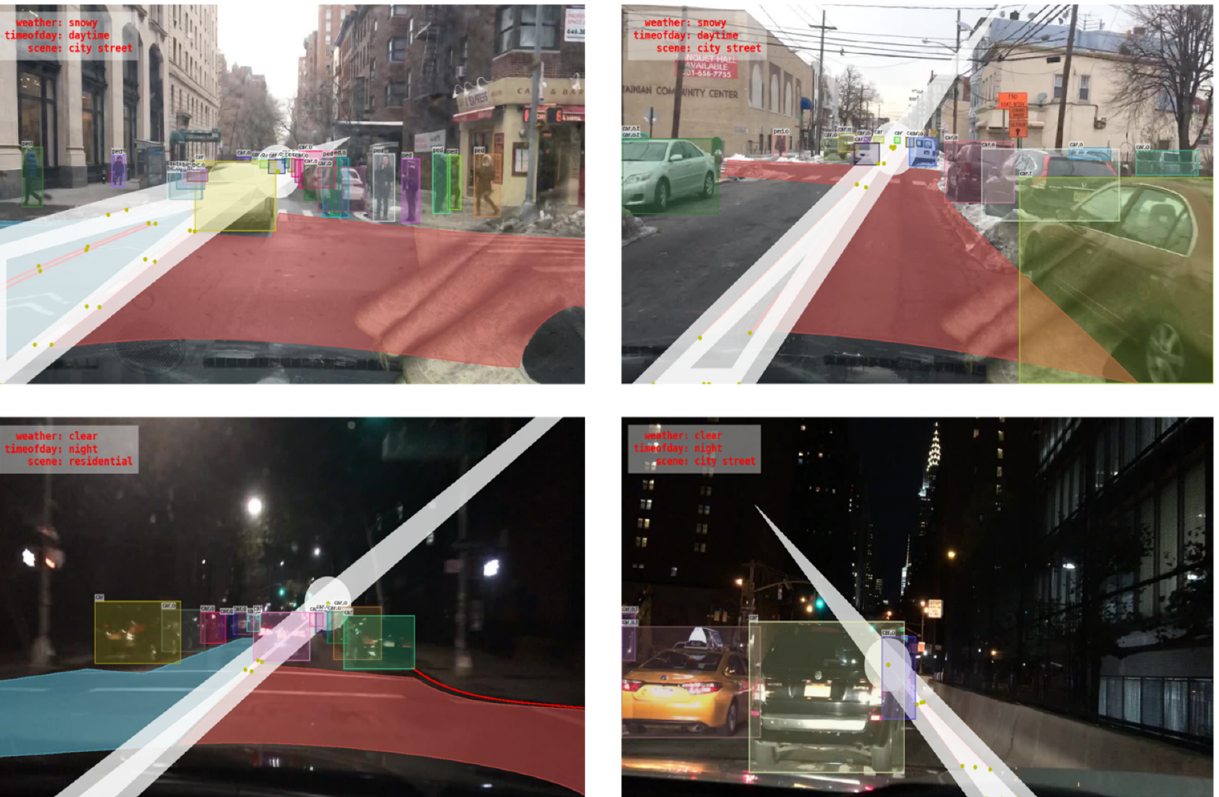
Figure 14. Failed filter mask generation examples.